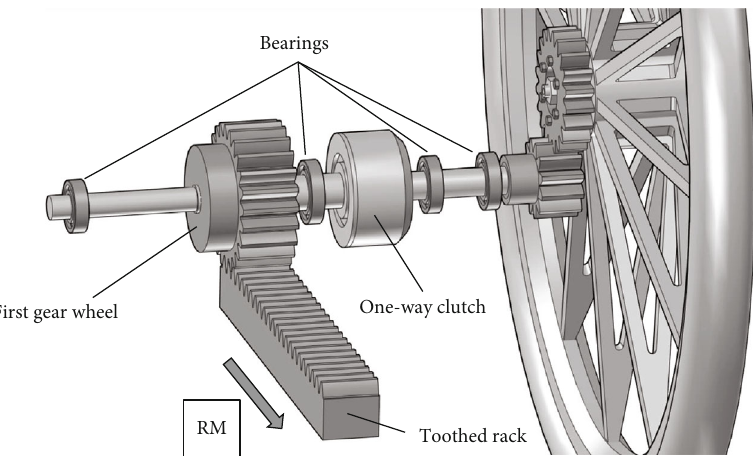
Figure 4: The gear transmission in the horizontal bike (detailed view).